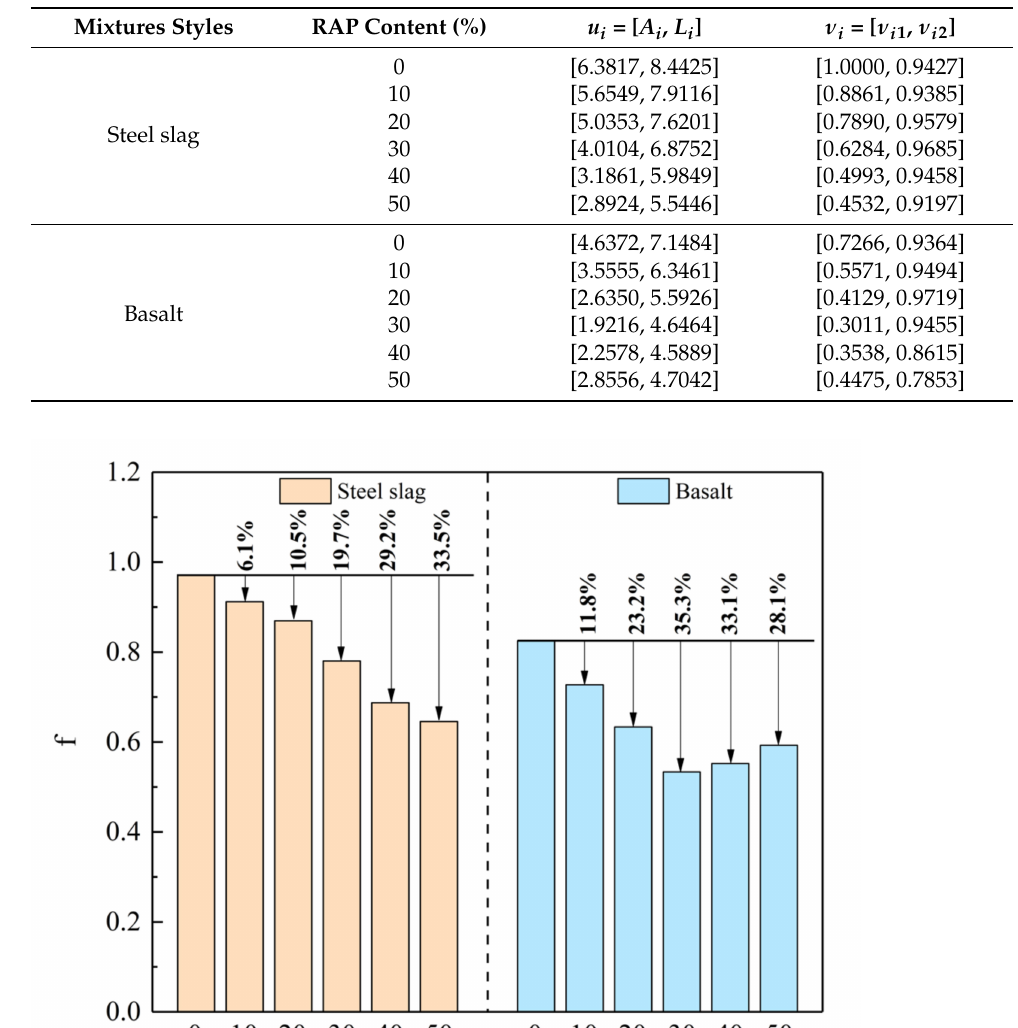
Table 8. The characteristic vectors and evaluation vectors of matrices.